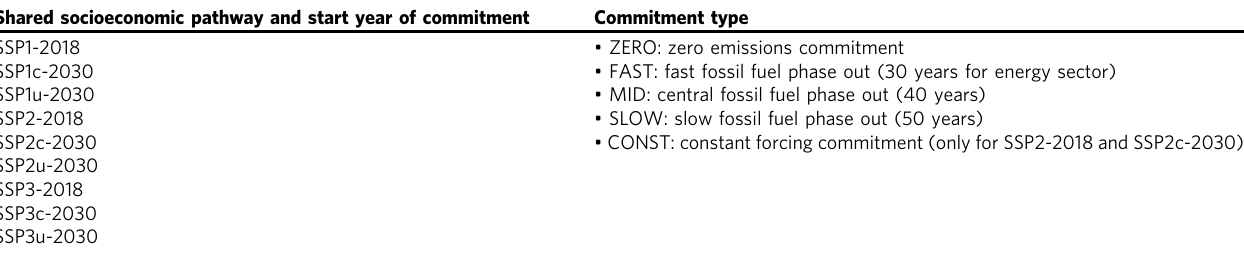
Table 1 Summary of scenarios used in this study Shared socioeconomic pathway and start year of